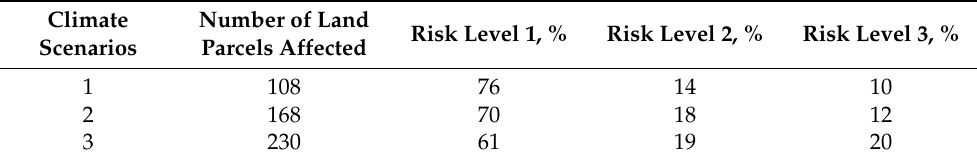
Table 4. Number of related properties and their risk levels for scenarios 1, 2 and 3 in